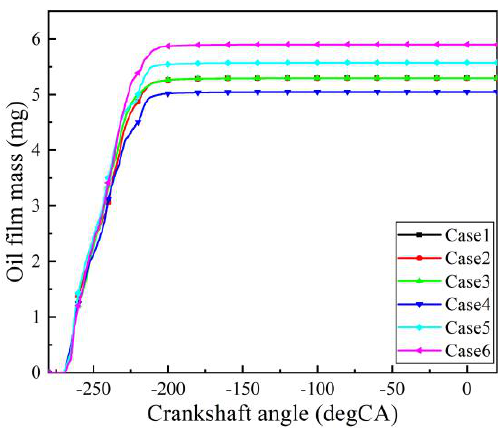
Figure 21. Oil film mass in different water injection cases (CR = 10.3, ignition time = − 14 degCA).